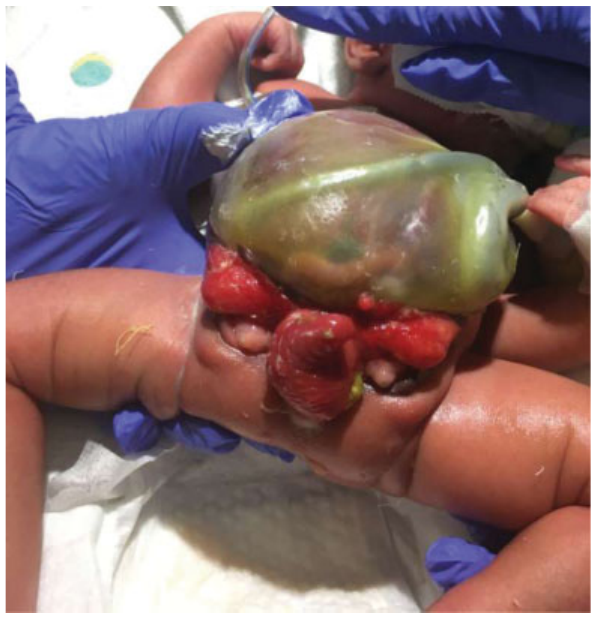
Fig. 1 Day of life 1: Inferior aspect with bladder plates and intus- suscepted ileum at cecal plate and large omphalocele.